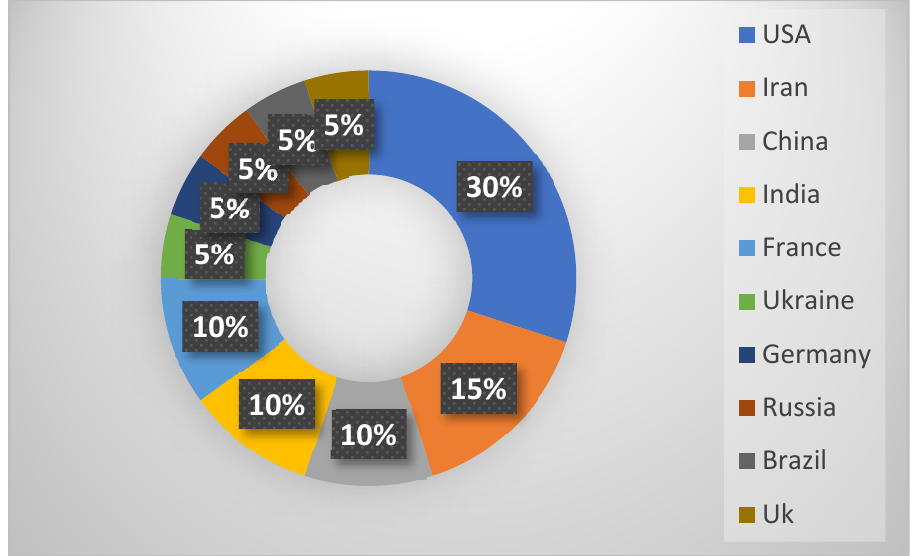
top 20 institutions/organizations for the years (2016–2018).